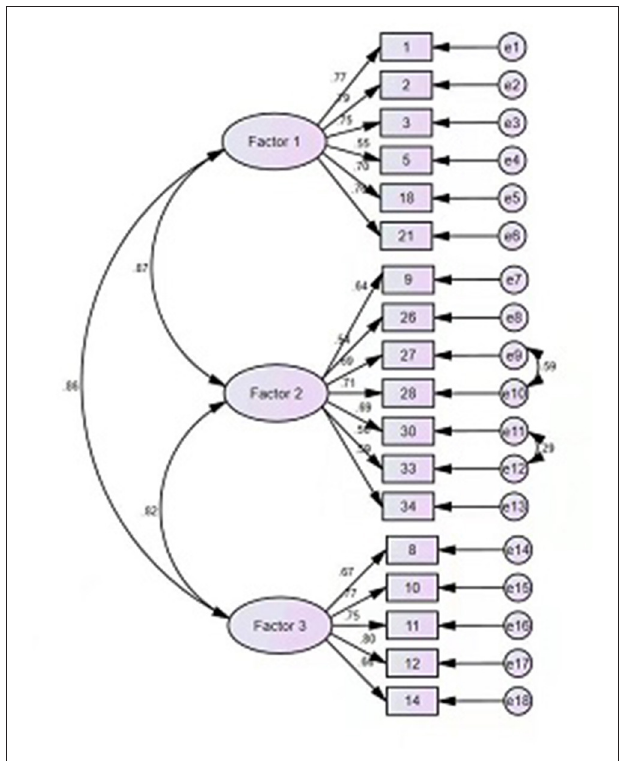
FIGURE 1 | Confirmatory factor